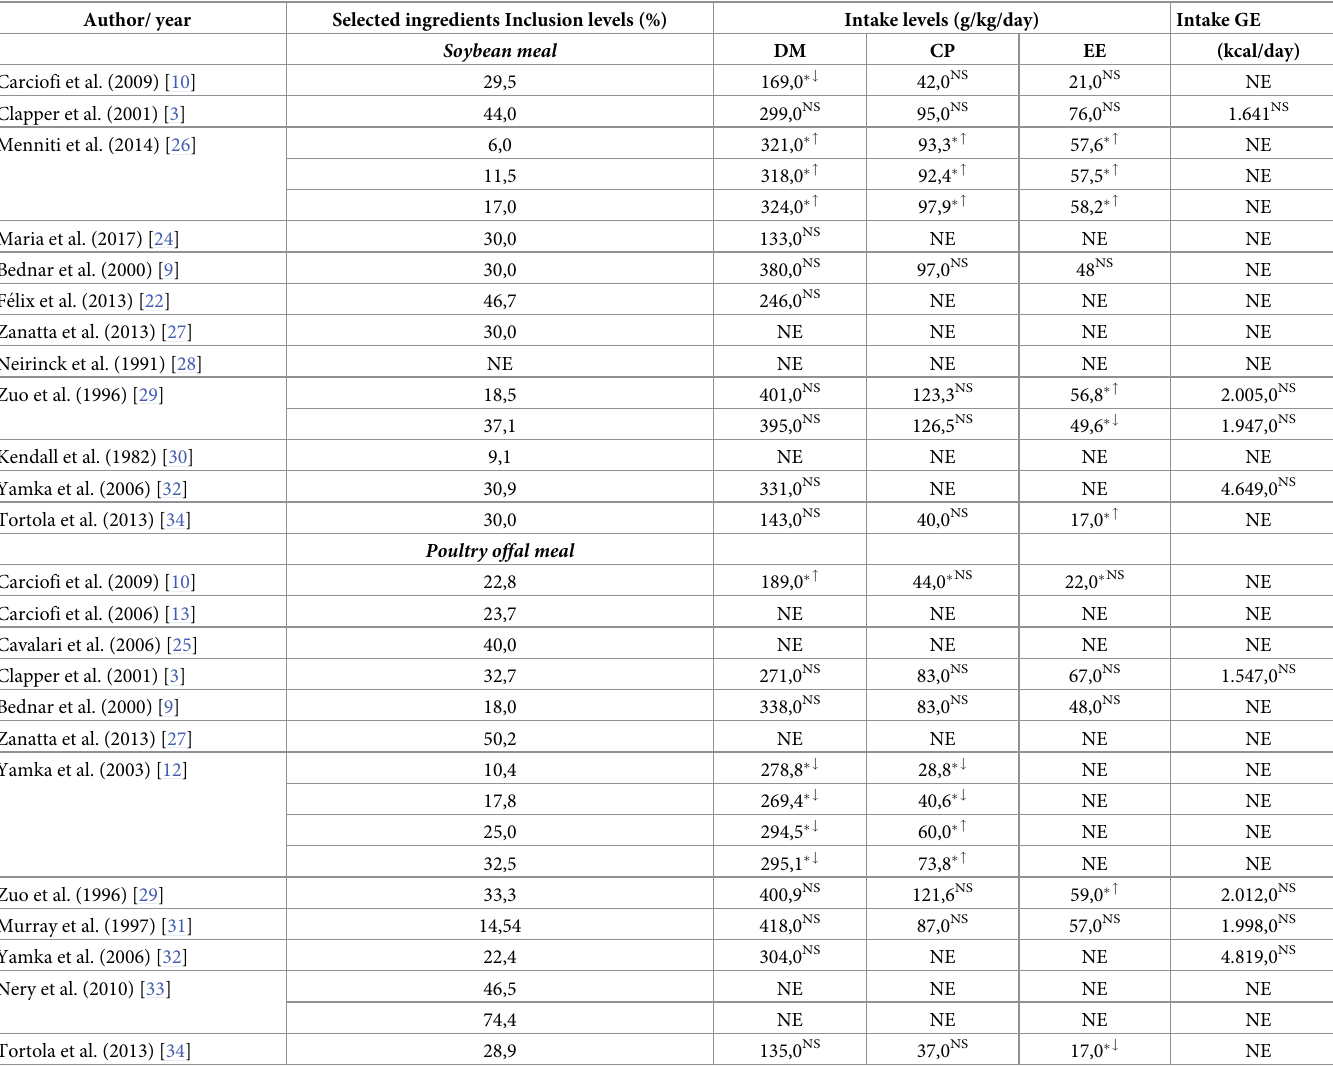
Table 4. Inclusion levels and intake levels of dry matter (DM), crude protein (CP), ether extract (EE), gross energy (GE) of soybean meal and poultry